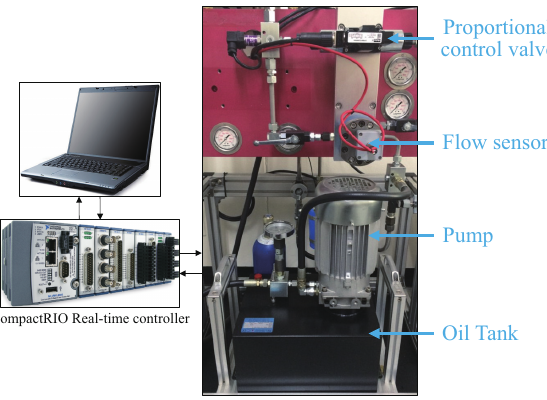
Figure 2. Schematic diagram of the experimental setup of the electro-hydraulic valve system.